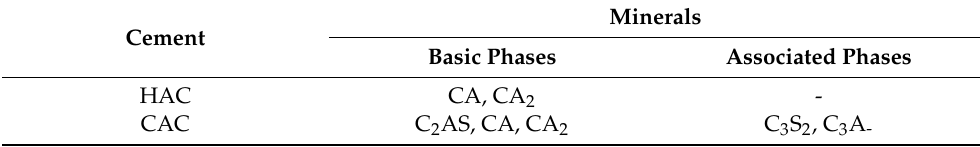
Table 1. The mineralogical composition of the tested types of cement.